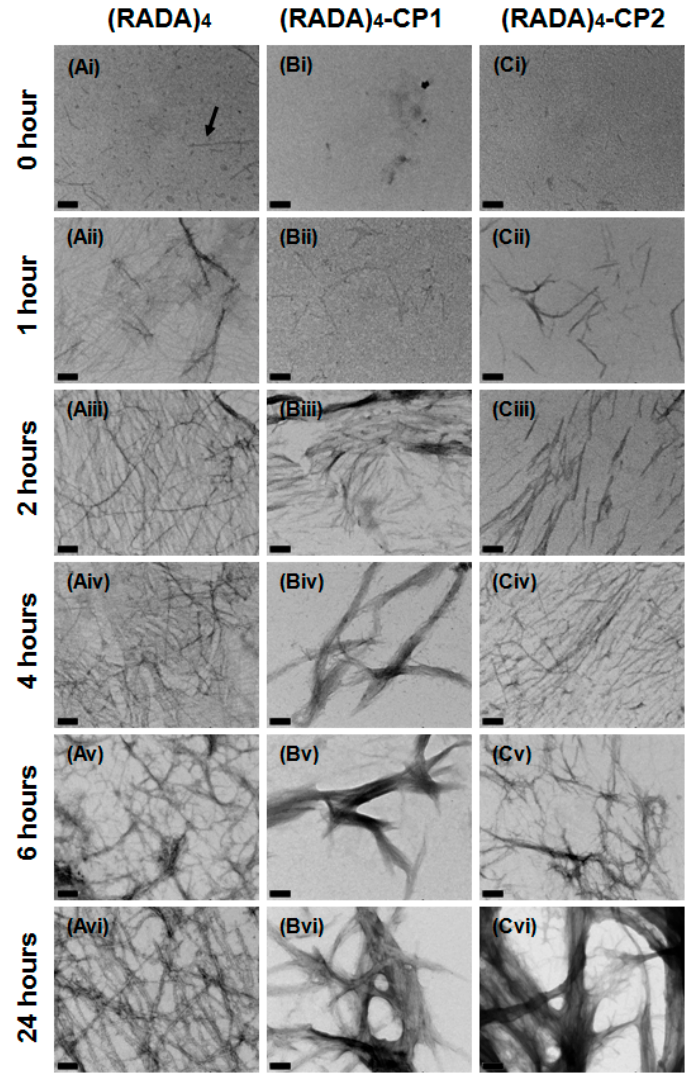
Figure 3. Transmission electron micrographs of ( A ) (RADA) 4 , ( B ) (RADA) 4 ‐ GG ‐ GPQG+IASQ, and ( C ) (RADA) 4 ‐ GG ‐ GPQG+PAGQ. Samples were sonicated for 30 min, incubated at 37 °C and pipetted onto grids at ( i ) 0, ( ii ) 1, ( iii ) 2, ( iv ) 4, ( v ) 6, and ( vi ) 24 h. All samples were stained with 4% uranyl acetate and imaged at 0.5% w / v in TNC buffer. Scale bars are 100 nm. Arrow ( Ai ) points to a discontinuous nanofiber.